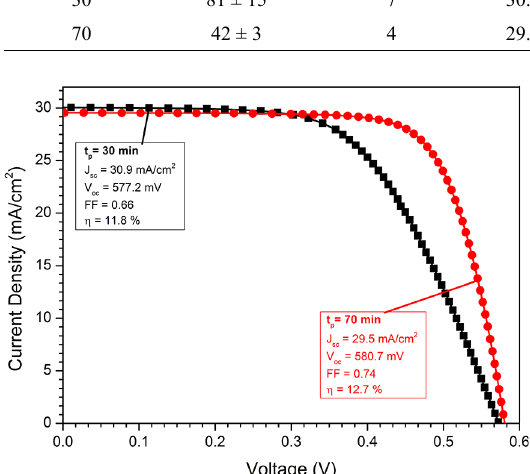
Figure 4. Electrical characteristics at standard conditions of solar cells with the highest efficiency, processed with POCl tube during 30 and 70 minutes at the temperature of 875 ºC.